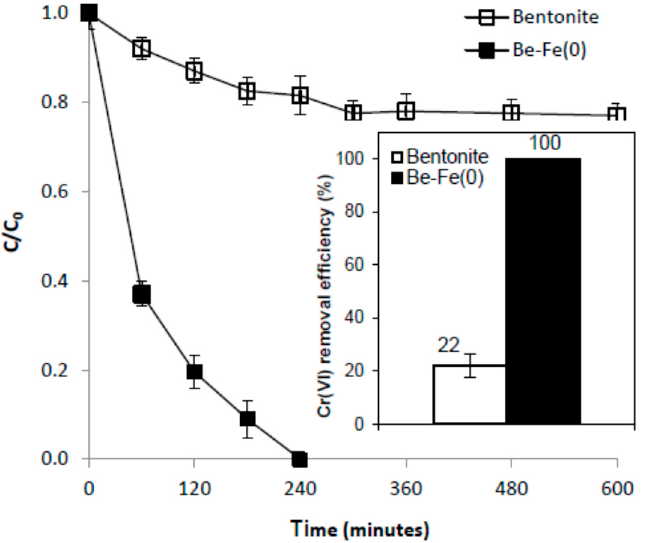
Figure 13. Comparison of Cr(VI) removal by Be-Fe(0) and bentonite.